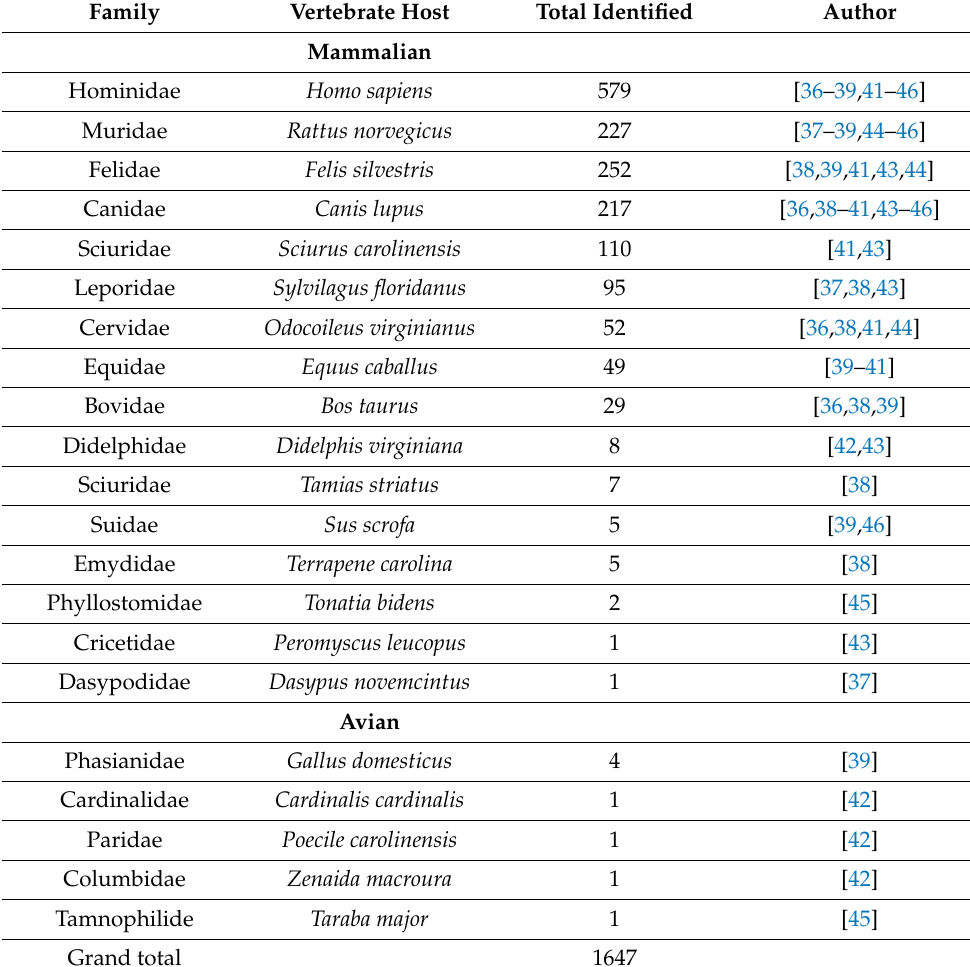
Table 2. DNA of vertebrate hosts identified in blood meals of Aedes